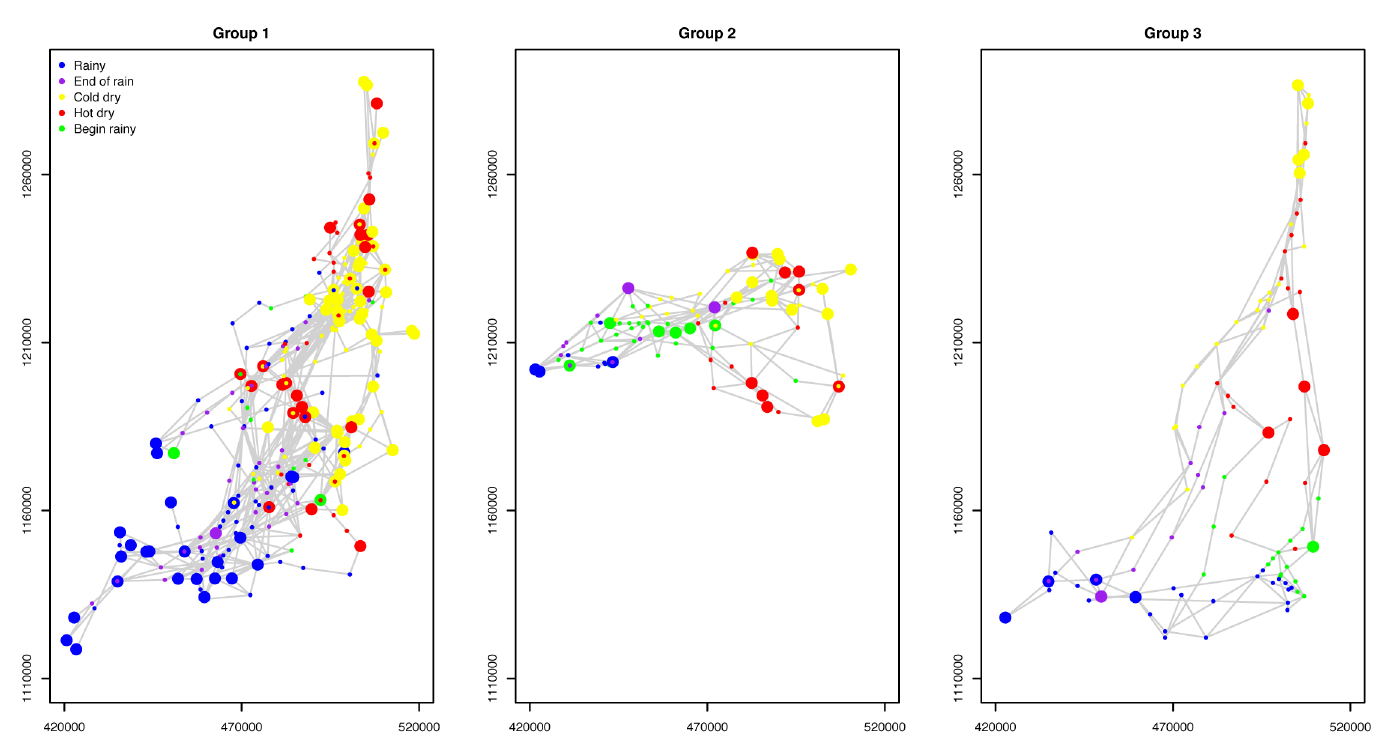
Fig 4. Three groups of transhumance